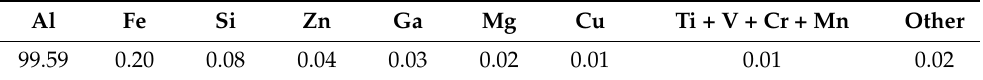
Table 3. Chemical composition of A7E-grade aluminum used by the manufacturer (wt.%) according to Ref. [39]. The lower limit of the Al weight content and the upper limits of possible impurities in the wire material are